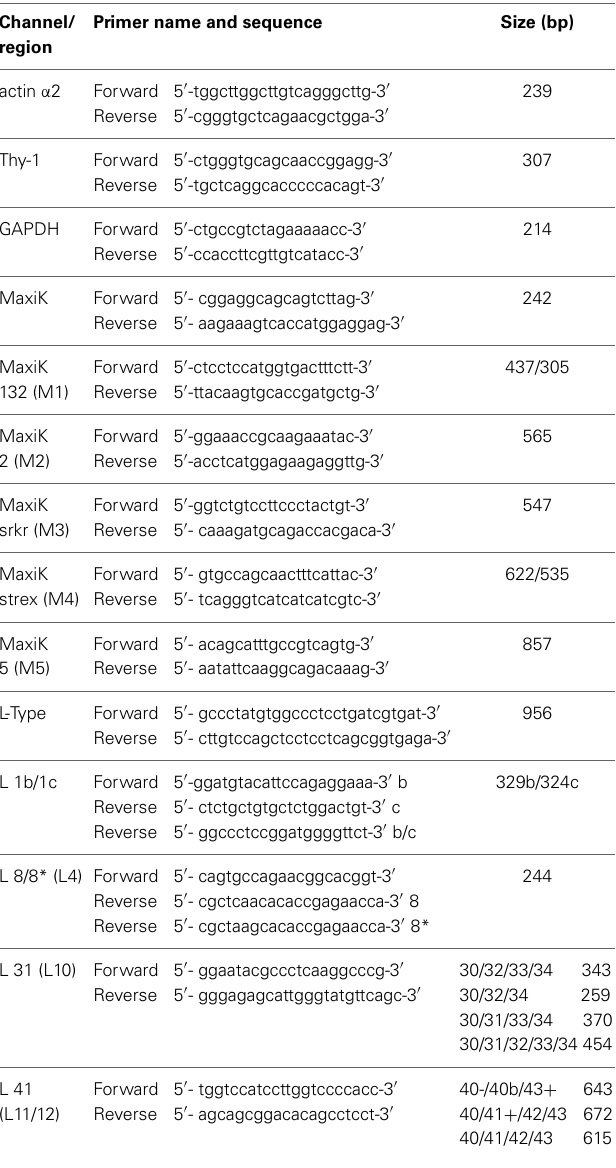
Table 1 | Sequences of primers employed in RT-PCR experiments in this study.